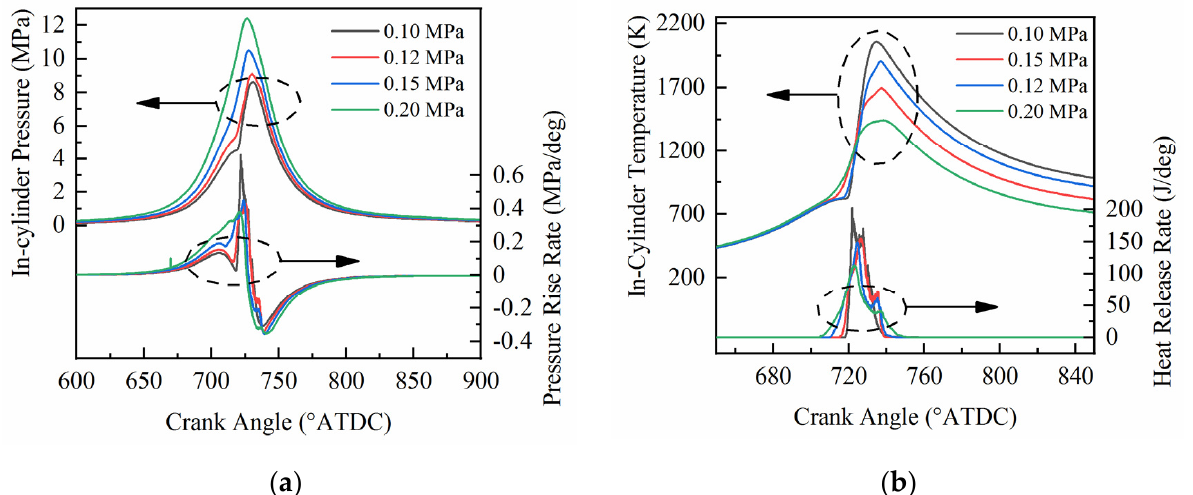
Figure 9. In-cylinder pressure and pressure rise rate ( a ) and in-cylinder temperature and heat-release rate ( b ) for different intake pressures (hydrogen mass fixed) [48].